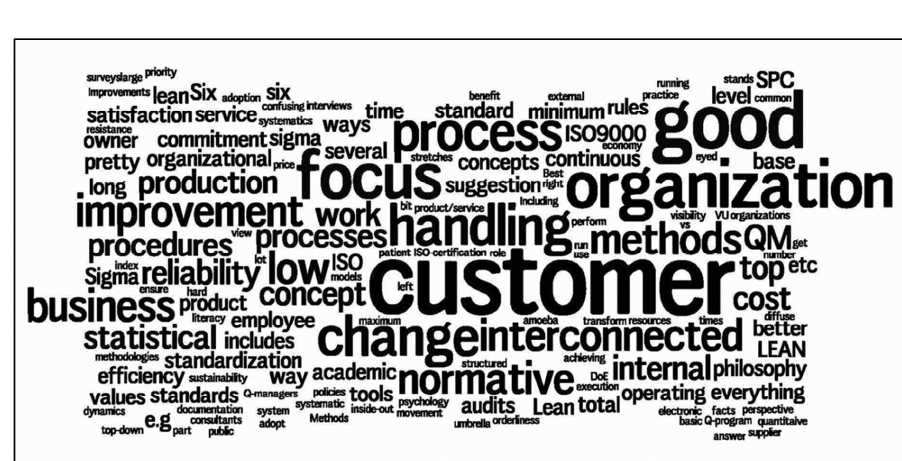
Figure 3 – Word cloud for QM today for all three universities, excluding “quality” and “management”